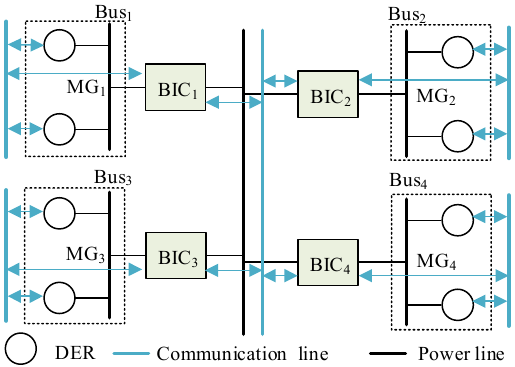
Figure 2. Topology of NMGs with multiple voltage levels.